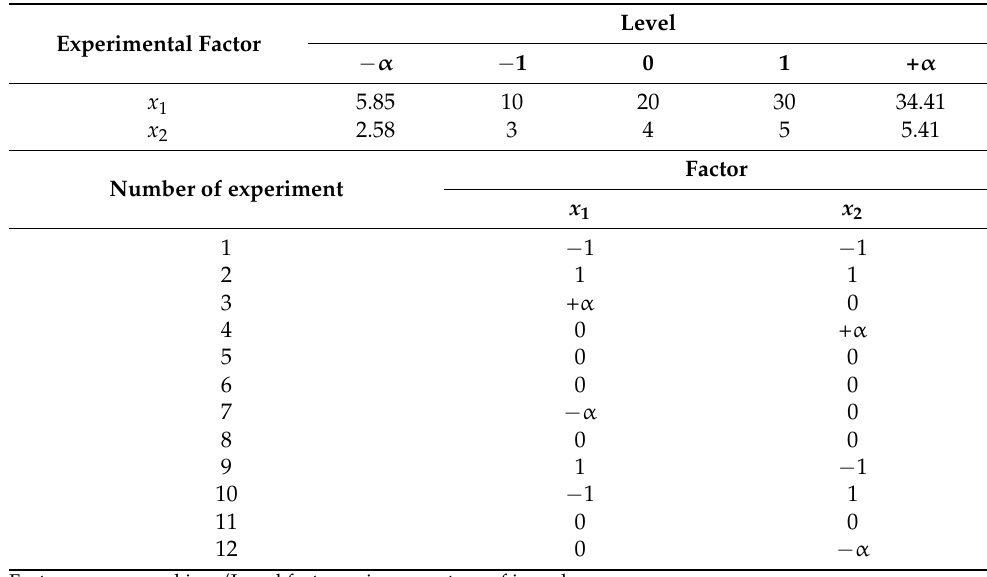
Table 1. Selected experimental factors for β -glucan ( x 1 ) and inoculum concentration ( x 2 ) for milk